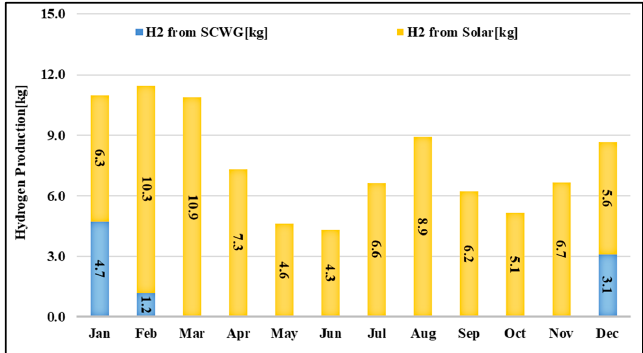
Figure 10. Monthly average electricity supply and demand in scenario 1: ( a ) total electricity generation from the HRES; ( b ) usage of the total electricity.